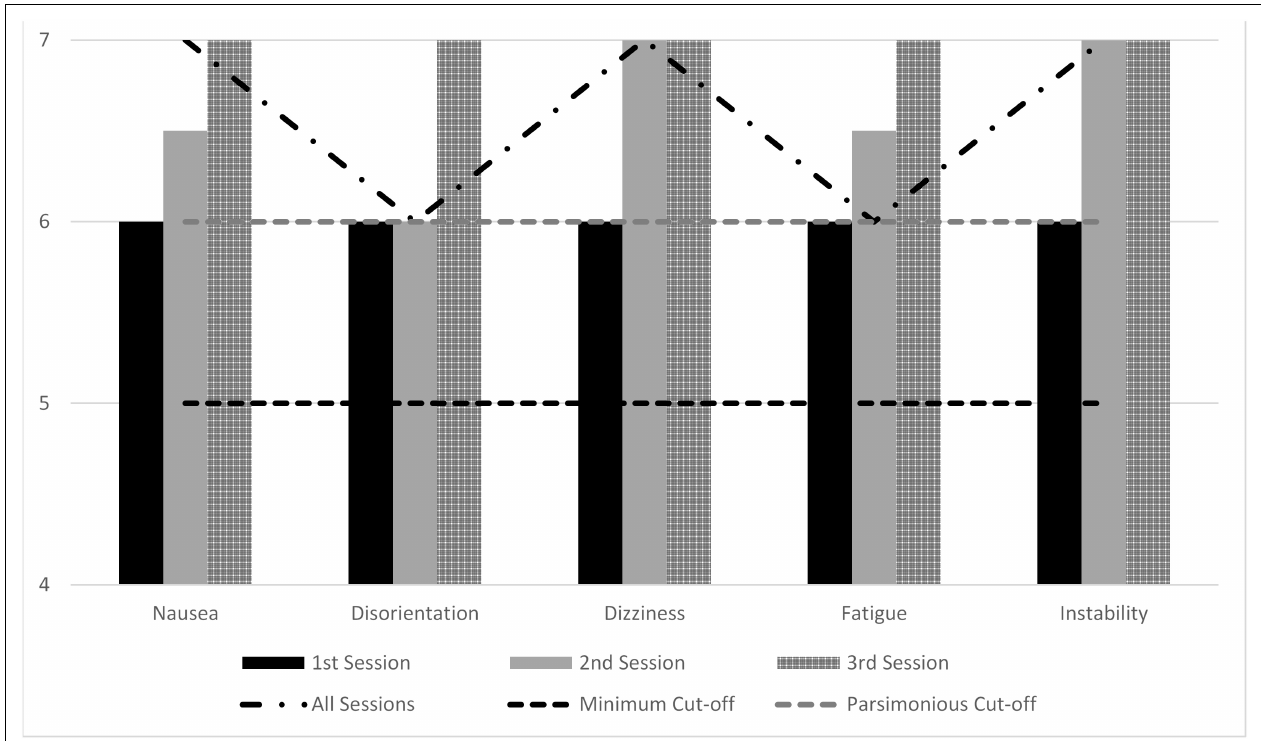
FIGURE 2 | VRISE intensity in VR sessions as measured by VRNQ. Median scores of VRISE items of VRNQ; VRNQ Minimum Cut-off ( ≥ ); VRNQ Parsimonious Cut-off ( ≥ ); 1, Extreme intense feeling; 2, Very intense feeling; 3, Intense feeling; 4, Moderate feeling; 5, Mild feeling; 6, Very mild feeling; 7, Absent